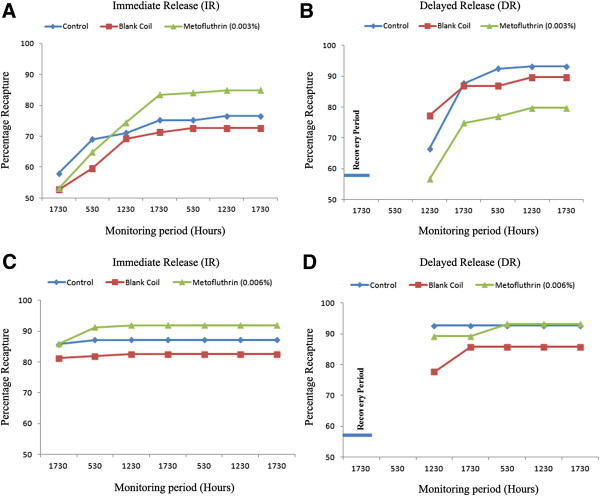
Cumulative BG-Sentinel™trap recaptures for Ae. aegypti females in trials using immediate release or delayed release of mosquitoes previously exposed to metofluthrin: A and B - low dose (0.003%) and C and D - high dose (0.006%).